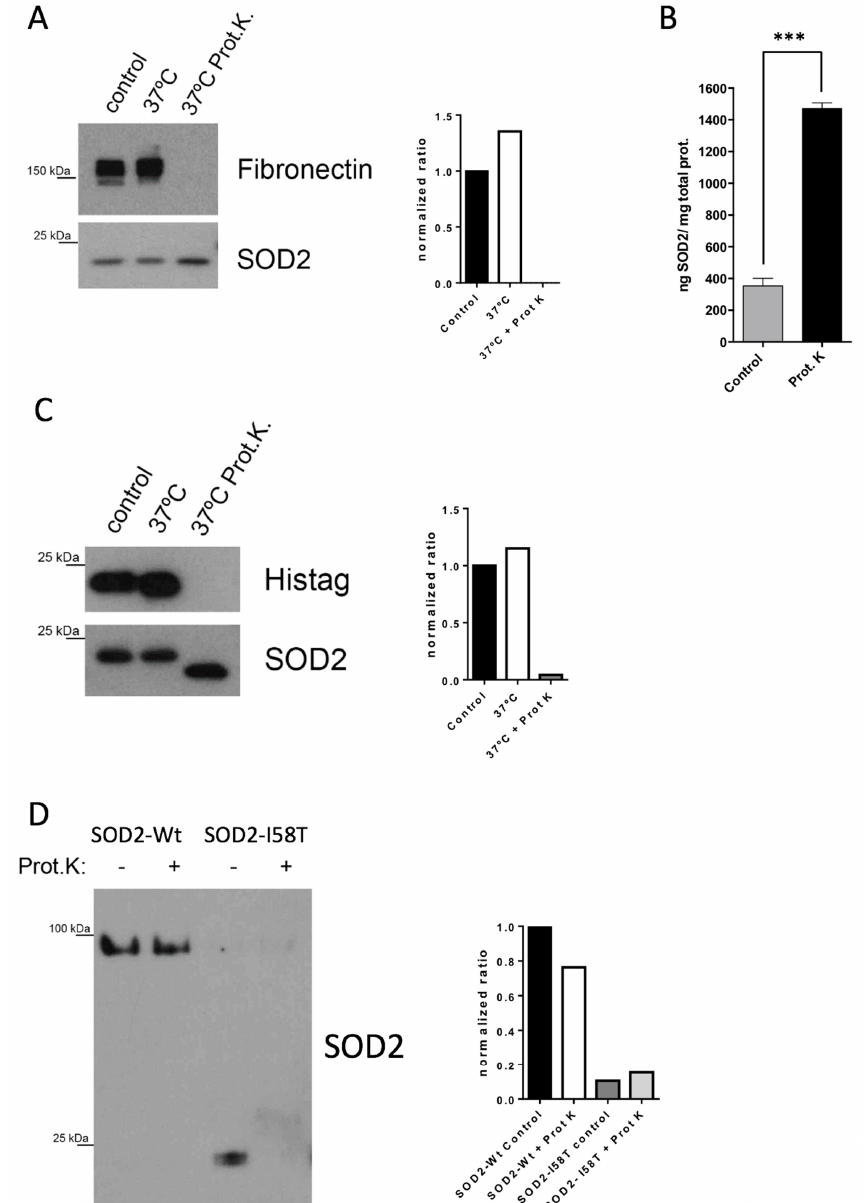
Figure 2. SOD2 is resistant to proteinase K degradation due to its quaternary structure. ( A ) The resistance of SOD2 to proteinase K activity was assessed by immunoblot in BT549 cells’ secretome and fibronectin was used as a degradation control. The secretomes were incubated at 37 ◦ C o/n with or without Prot K, and a non-treated secretome was loaded as control. ( B ) SOD2 levels are also enriched in the digested BT549 secretome, when the samples are analyzed by ELISA. The mean of the triplicates and SD is shown. *** p -value < 0.001 ( C ) WB showing that SOD2 recombinant protein is resistant to Prot K activity, except for its His-tag that is digested after incubation with Prot K. ( D ) SOD2-I58T mutant is unable to form tetramers and is sensitive to Prot K. The secretomes from BT549 WT cells and BT549-shSOD2 -I58T cells were incubated with or without Prot K. Secretomes were loaded into native non-SDS-PAGE to evaluate the quaternary structure of the proteins. Quantification of the immunoblot bands was performed with Image J. Protein levels were normalized to the control condition of each experiment (Figure